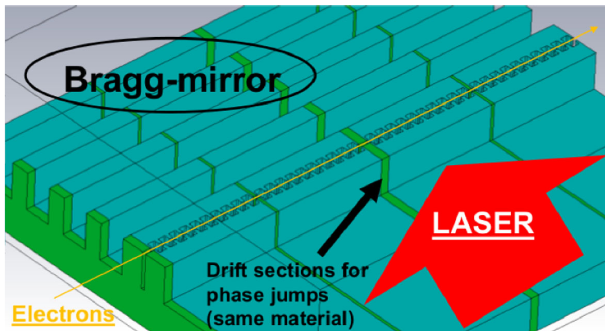
FIG. 1. Example Bragg cavity grating with a Bragg mirror on one